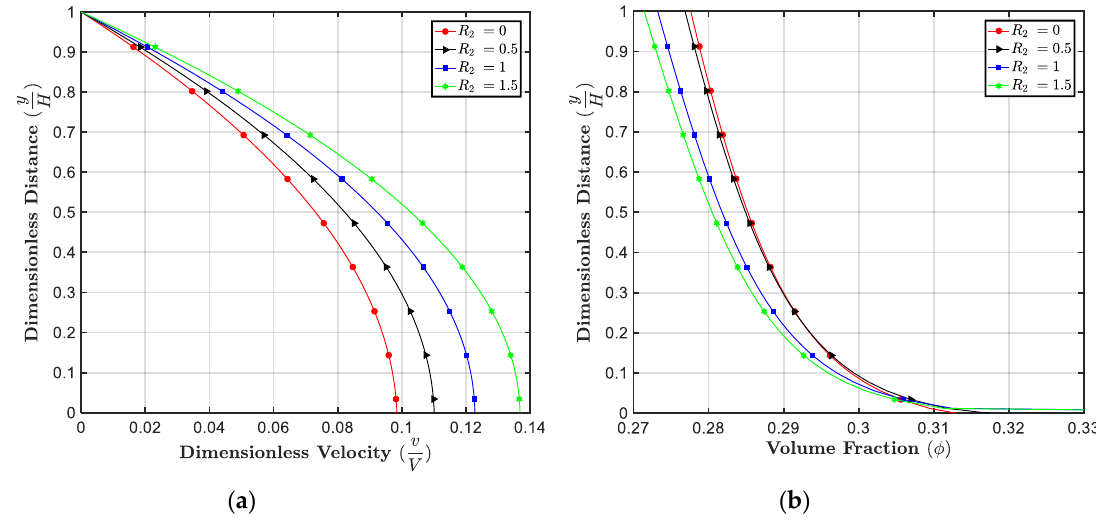
Figure 14. Effect of 𝑅 1 on ( a ) the velocity; and ( b ) the volume fraction profiles, with 𝛽 = 1.82, 𝜙 𝑎𝑣𝑔 = 0.3, 𝑅 0 = 0.1, 𝑅 1 = − 2.5, 𝑅 3 = 0.01, 𝑅 4 = 0.07, 𝑅 5 = 1.8, 𝐾 𝑐 𝐾 𝜇 = 0.05, 𝜙 𝑚 = 0.65, 𝑚 = 1, 𝜃 = 45°.